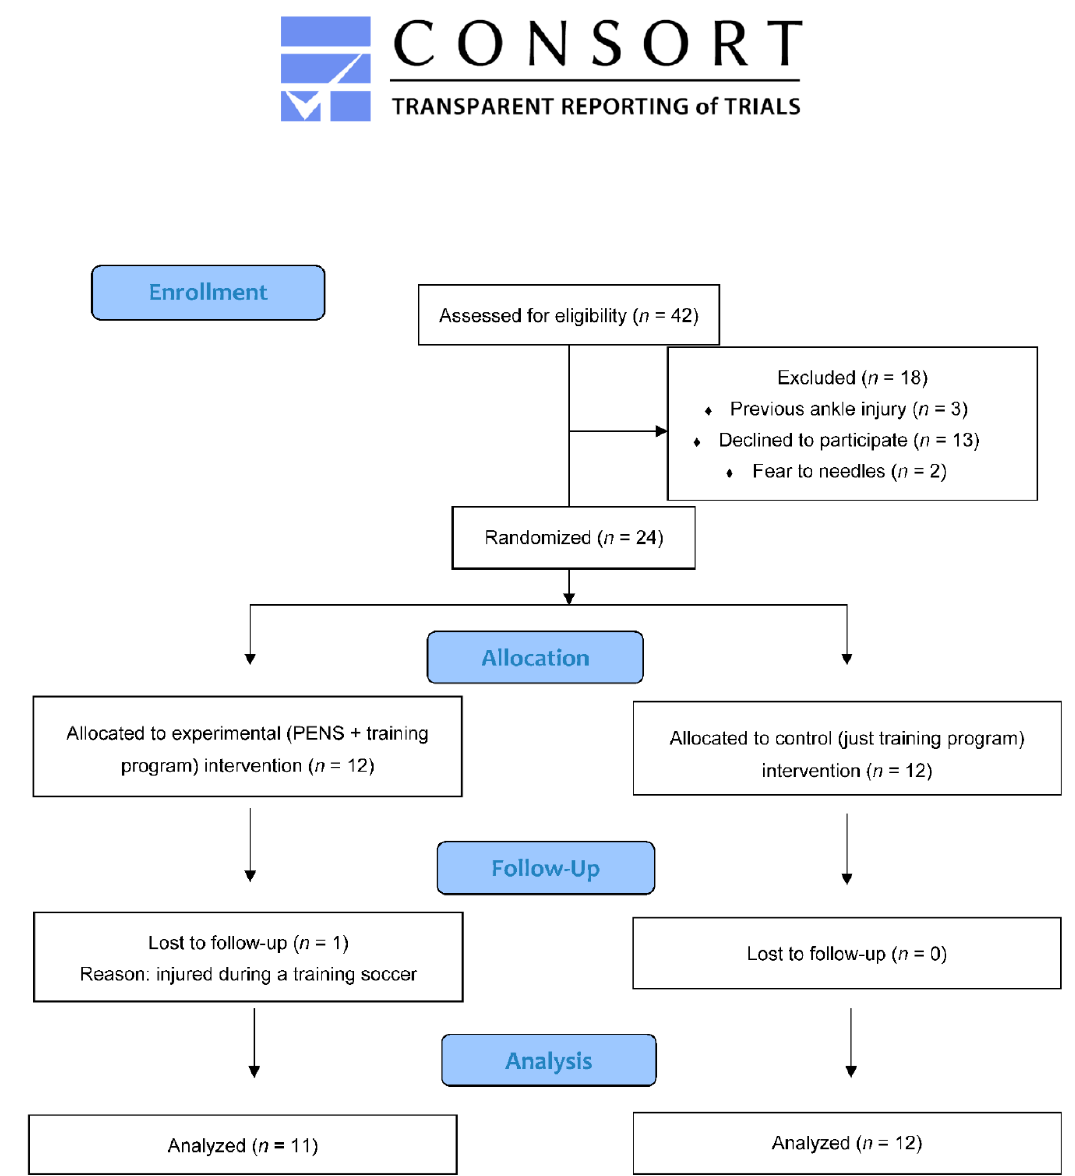
Figure 4. CONSORT 2010 Flow Diagram.